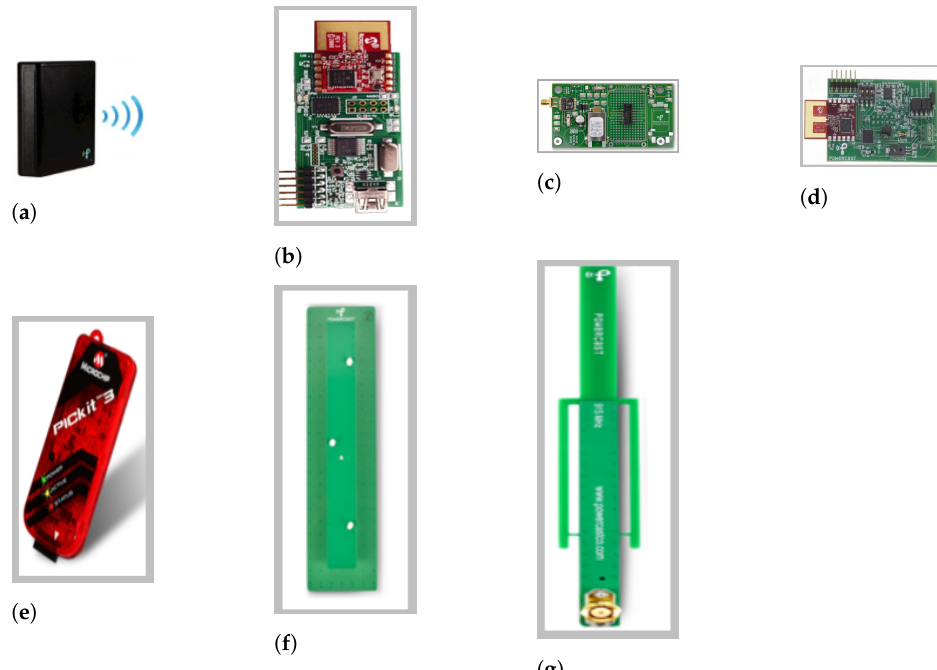
Figure 2. Powercast Kit components consist of: ( a ) TX91501-3W Transmitter; ( b ) access point WSN- AP-01; ( c ) harvester P2110-EVB; ( d ) wireless sensor board WSN-EVAL-01; ( e ) pickit-3; ( f ) patch antenna and ( g ) dipole antenna.